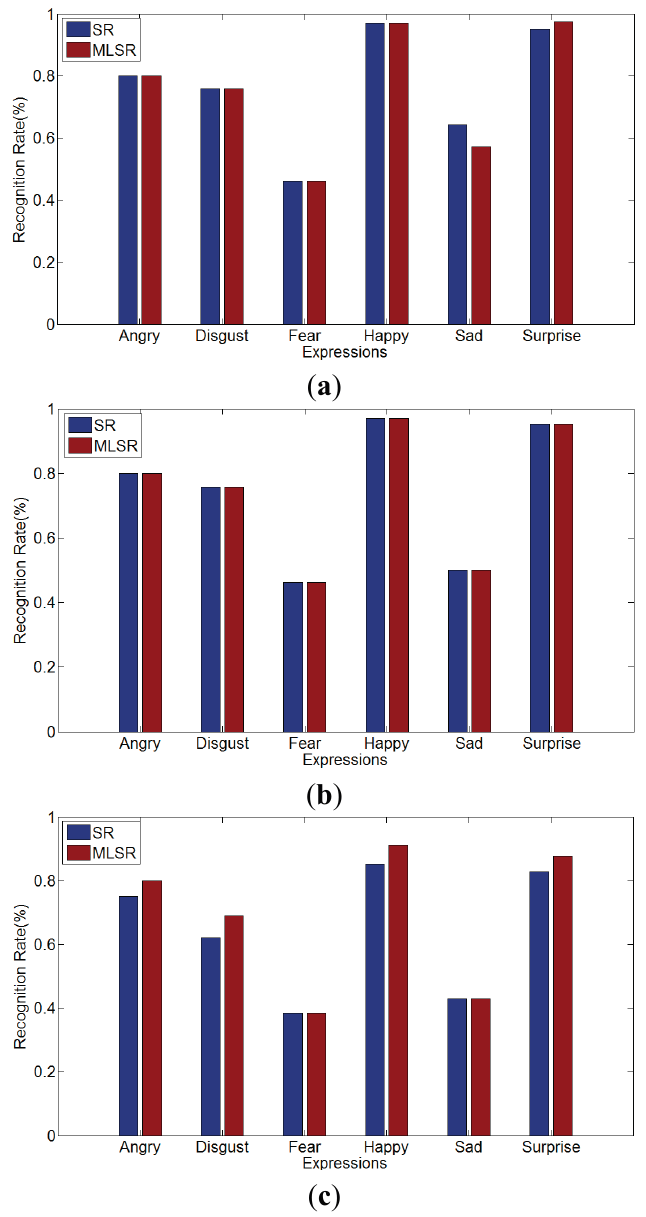
Figure 9. The comparison between MLSR and SR about multi-intensity recognition. ( a ) High intensity; ( b ) Moderate intensity; ( c ) Low